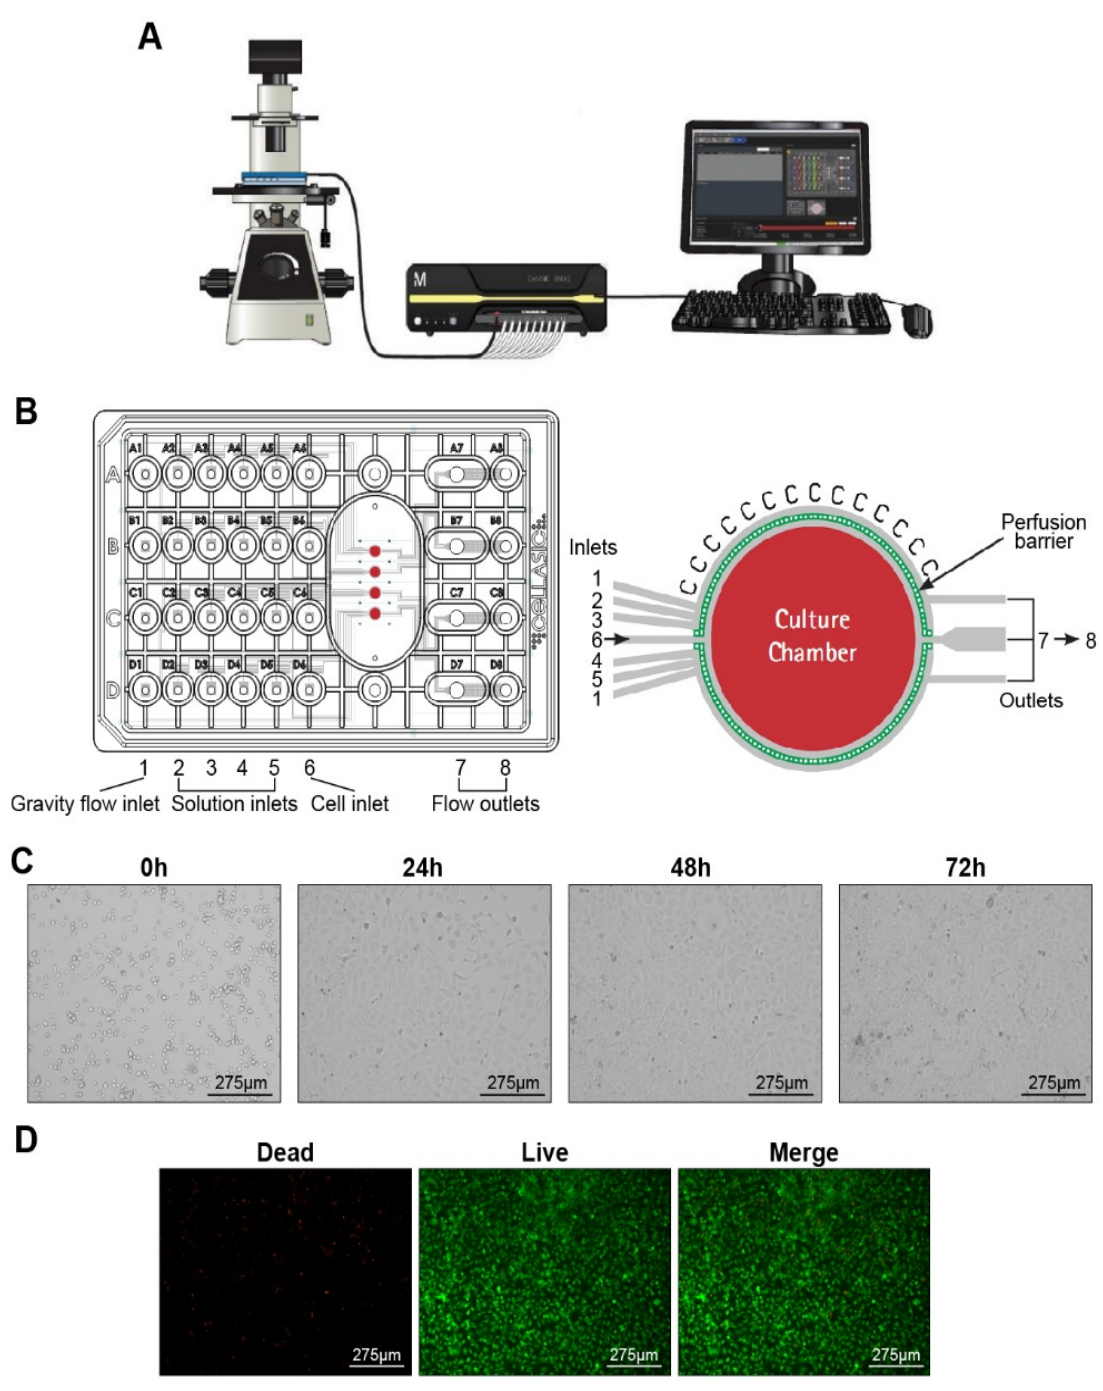
Figure 2. Design of a CellASIC-based microfluidic platform to culture glomerular endothelial cells. ( A ) CellASIC ONIX2 Microfluidic Platform. The Platform consists of a controller system including multiple control panels, a computer software interface and a fluorescent inverted microscope. ( B ) Configuration of the microfluidic chip device. The microfluidic plate consists of four independent culture units, each with a gravity flow inlet (1), four solution inlets (2–5), and a cell inlet (6). Each row of wells addresses the corresponding culture chamber. ( C ) Bright-field images showing that HRGECs grew on the microfluidic chip at different culture times (0, 1, 2, 3 d). ( D ) Fluorescence images of live/dead staining of HRGECs after 3 days of culture on the